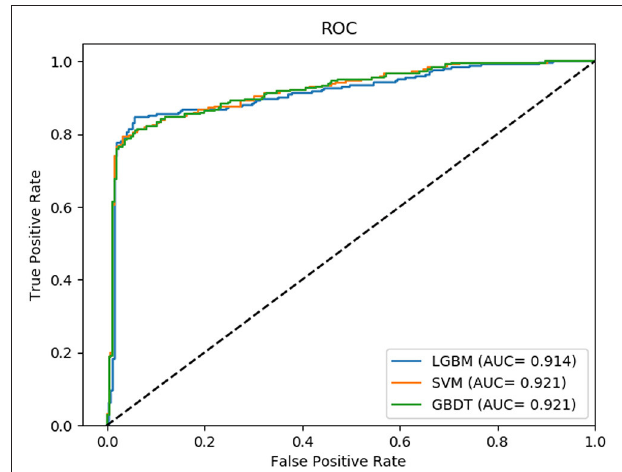
FIGURE 3 | The ROC curve of dataset RPI488 on three